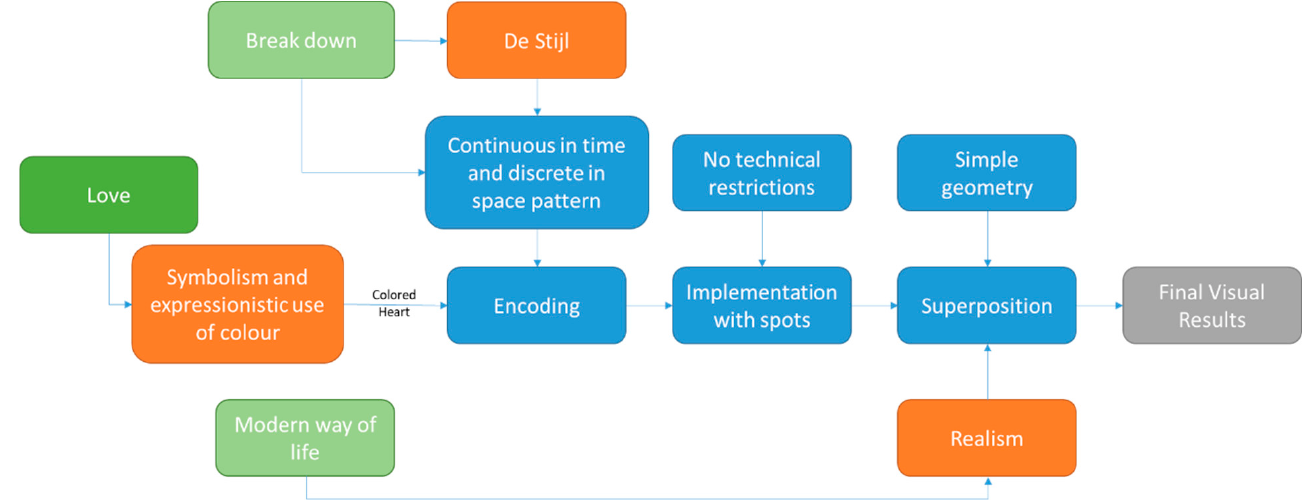
Figure 12. Simulation of visual result of Working Diagram I—Scene 7.